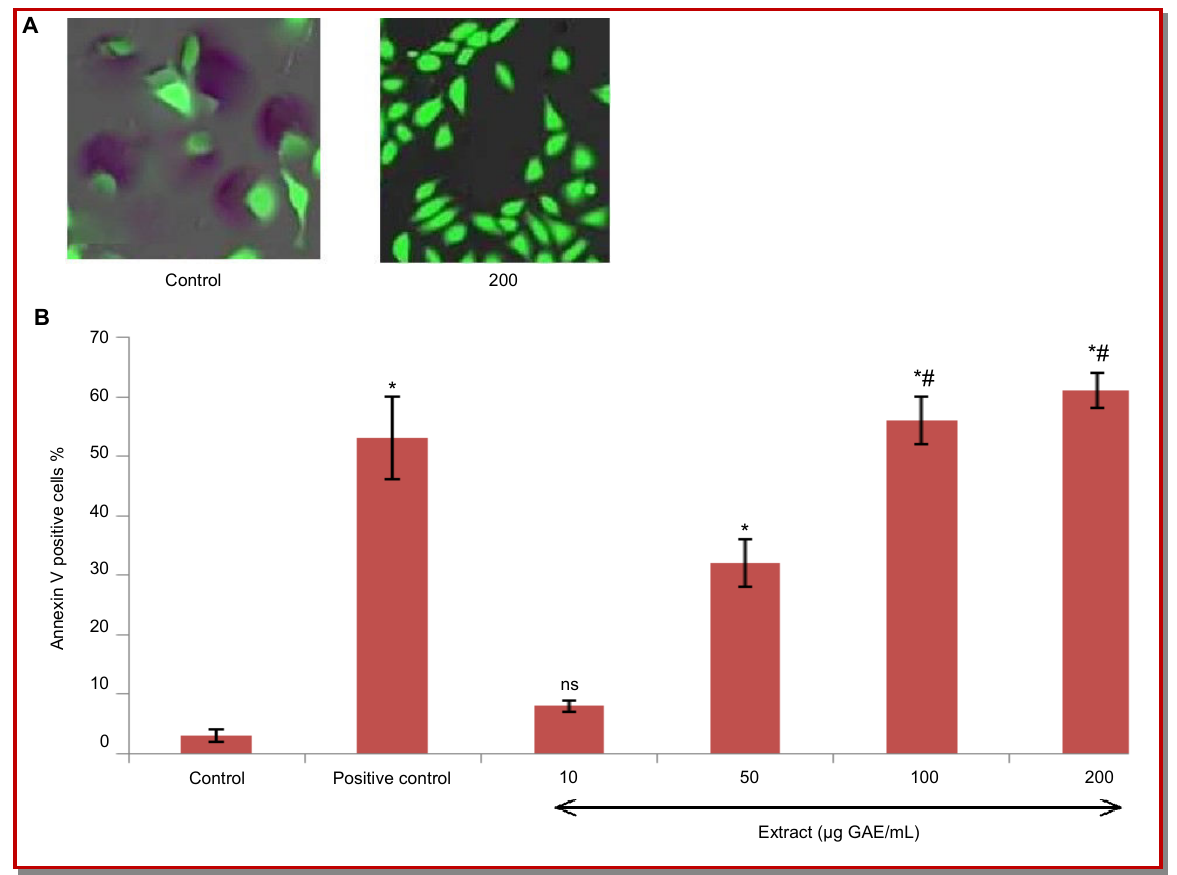
Figure 5: A. Fluorescent image of U-2 osteosarcoma cells. B. Effect of extract of different GAE concentrations on apoptotic cells in terms of annexin V positive cells. Results are represented as the mean of %annexin V positive cells with error bars representing SD from three experiments. Positive control represented the treatment of the cells with 10 µg/mL vincristine. *represents significant difference and ‘ns’ represented non significant difference at p<0.05 from the untreated control and #represents the non signi fi- cance i.e. equivalence in comparison to standard (vincristine 10 µg/mL) positive